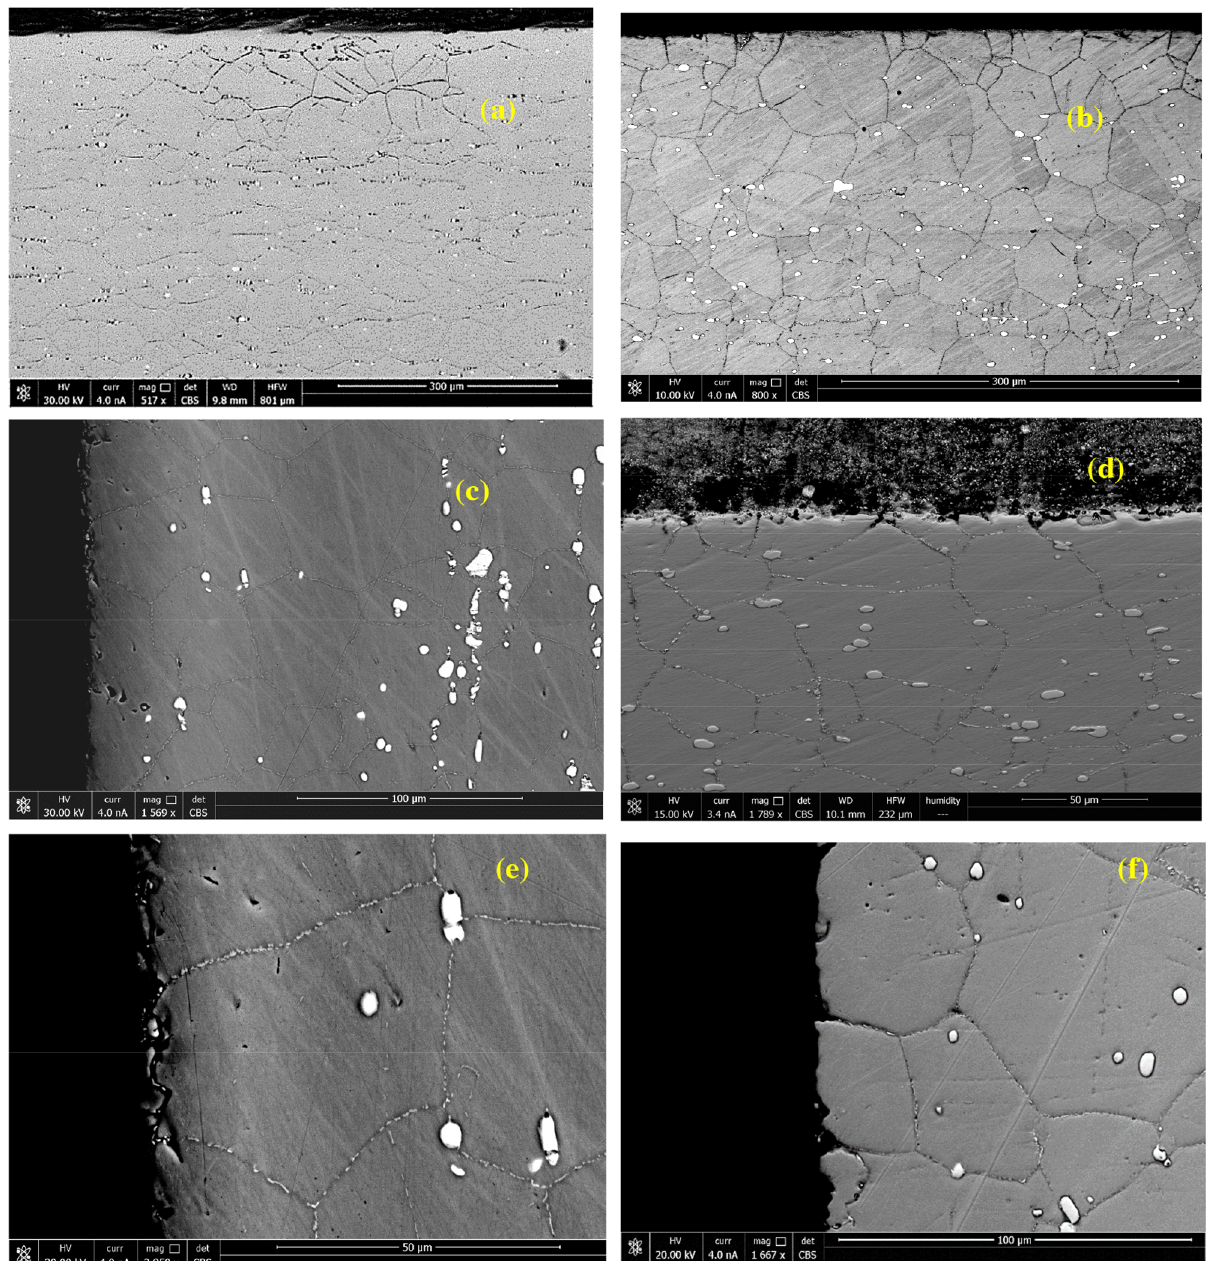
Fig. 7. SEM images of metallographic structure of the undersurface layer for the Hastelloy-N after exposure in fuel 71.2LiF-26.8BeF 2 - 2UF 4 salt containing tellurium: (a), (c), (e) after exposure with [U(IV)]/[U(III)] ratio 42 at T =760 ° C (left), (b), (d), (f) after exposure with [U(IV)]/[U(III)] ratio 85 at T =800 ° C